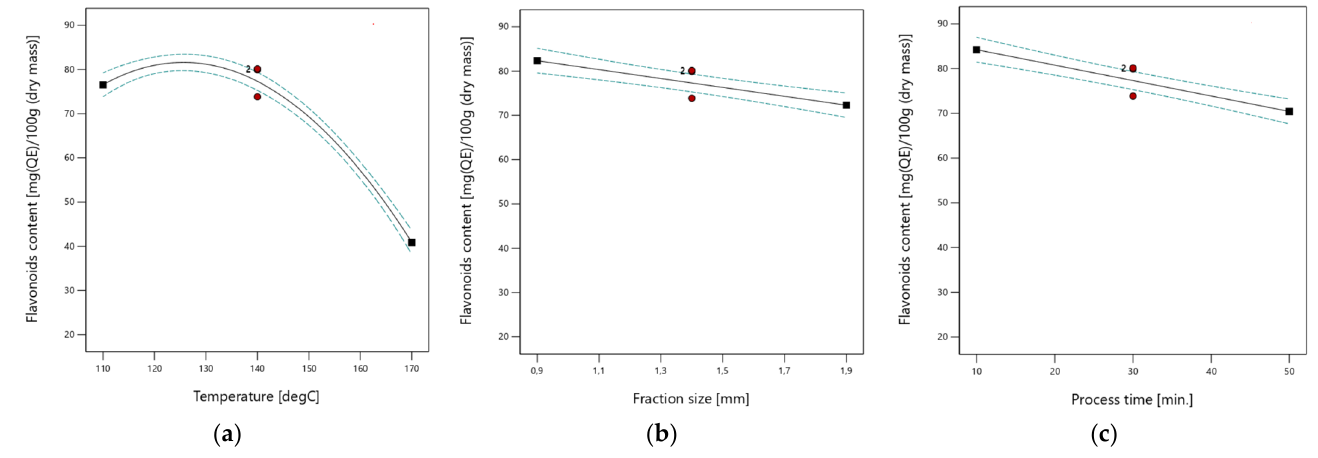
Figure 3. Flavonoids content for different subcritical extraction parameters ( a ) Flavonoids content as a function of extraction temperature; ( b ) Flavonoids content as a function of raw material fraction size; ( c ) Flavonoids content as a function of process time.